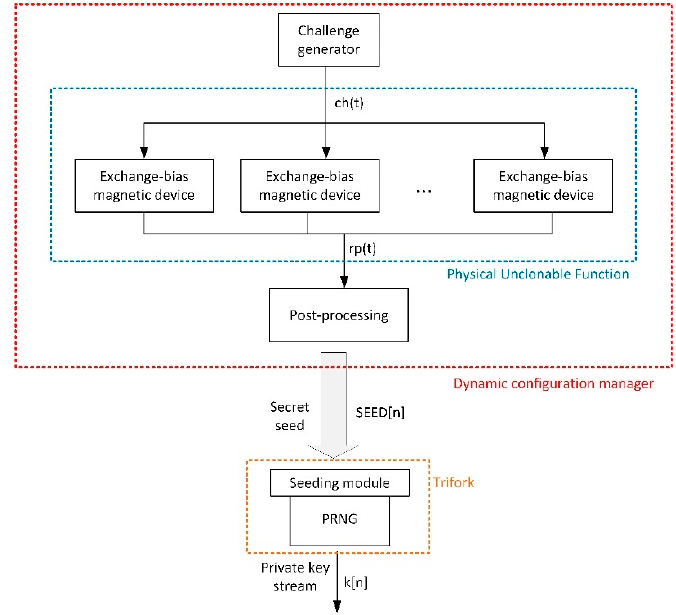
Figure 3. PUF-based key generator.